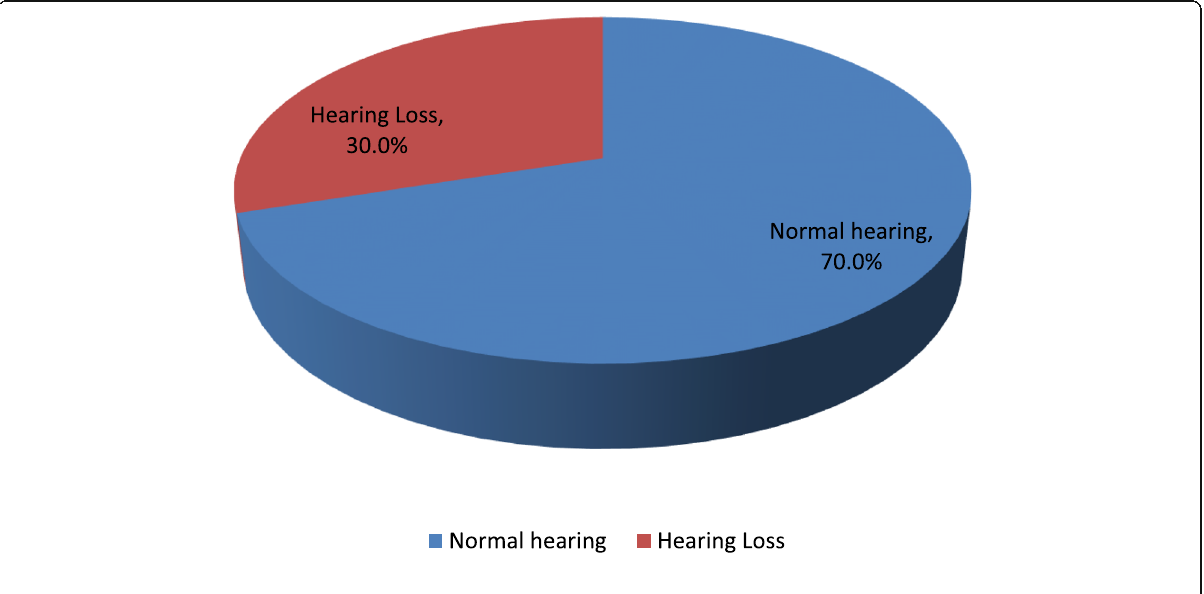
Fig. 1 Distribution of hearing status among the hypertensive